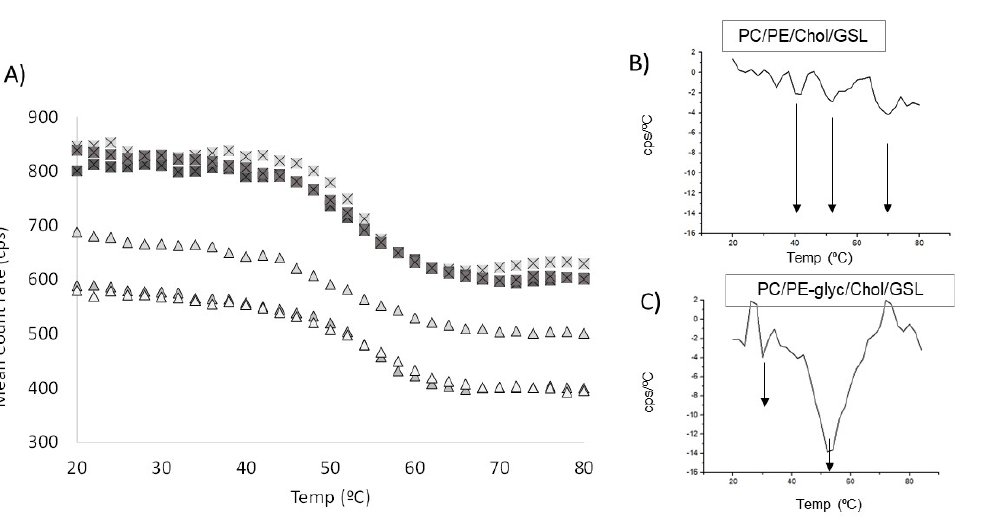
Figure 4. Plots of ( A ) mean count rate for the epithelial membrane model under normoglycaemia (DPPC/DSPC/DMPE/Chol/GSL, triangles) and hyperglycaemia conditions (DPPC/DSPC/DMPE/DMPE-glyc/Chol/GSL, crossed squares), ( B ) first-derivative of mean count rate plot under normoglycaemia conditions (PL/Chol/GSL) and ( C ) first-derivative of mean count rate plot under hyperglycaemia conditions (PL/DMPE-glyc/Chol/GSL). Mean count rate measurements correspond to independent experiments (n = 3).